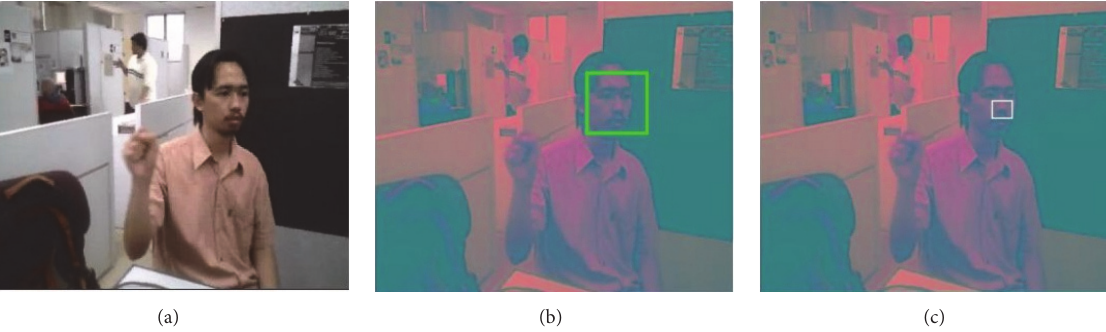
Figure 5: The output of face and nose regions detection using Viola–Jones algorithm.